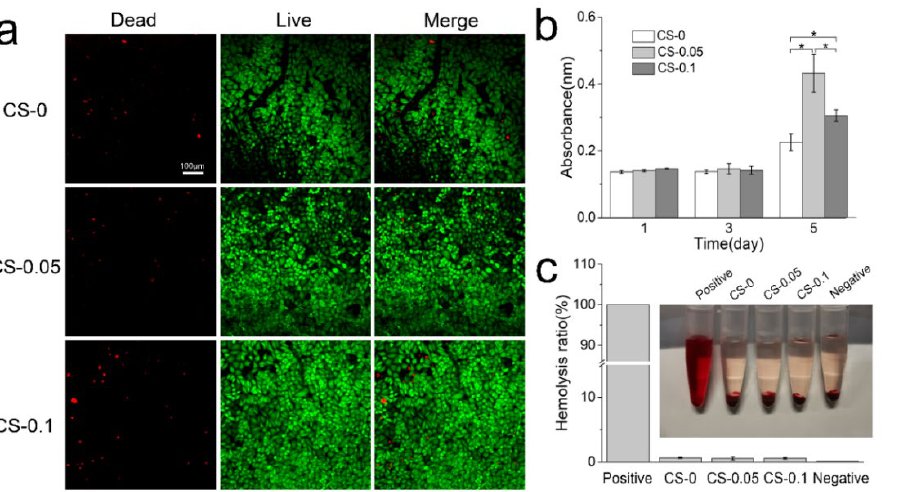
Figure 7. ( a ) Live and dead staining of HUVECs; ( b ) proliferation rates of HUVECs on different hydrogels; and ( c ) the hemolysis ratios of various hydrogels, * p < 0.05. The hemocompatibility of hydrogels is identified in Figure 7c. Erythrocytes swell and burst in the positive group (DI water), while hydrogels and the negative group (PBS) show a similar canary yellow color to the normal saline. Quantitative evaluation reveals low hemolysis rates in all groups, which are below the internationally permitted level of 5% [24], indicating that these hydrogels do not cause serious hemolysis, and would be suitable for biomedical applications